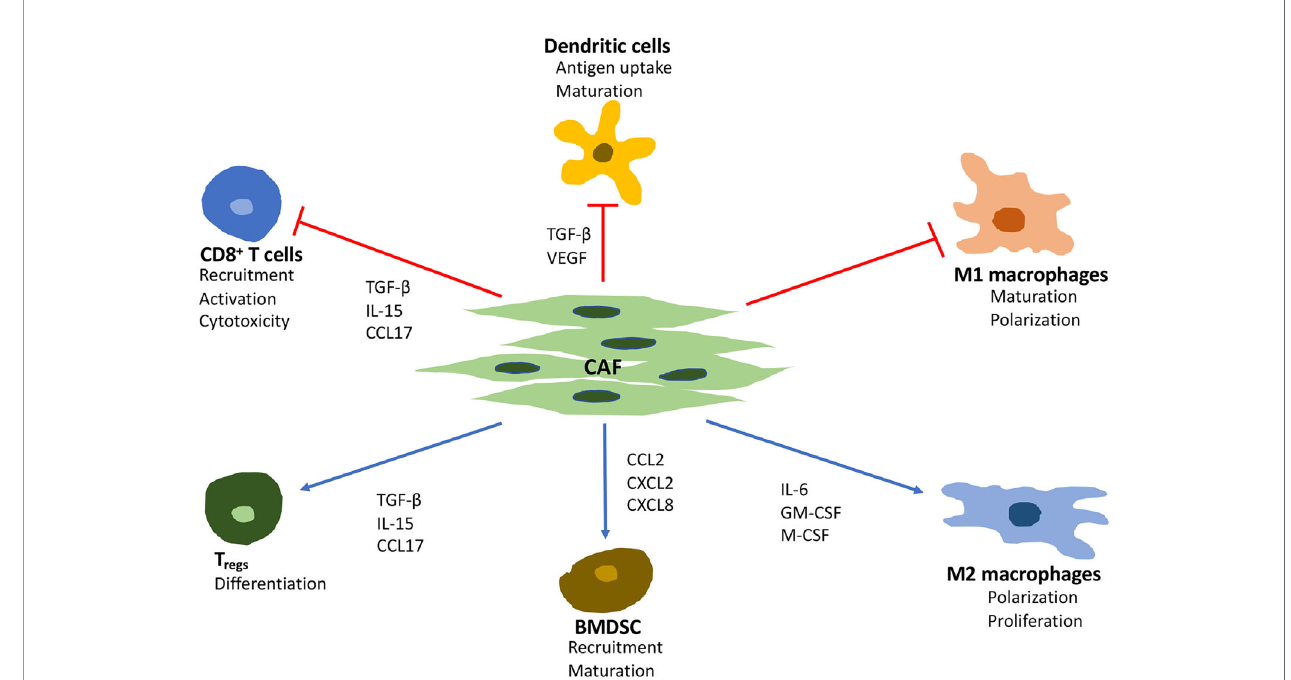
FIGURE 1 | Major effects of CAF on immune cells in the tumor microenvironment. TGF- b , transforming growth factor beta; VEGF, vascular endothelial growth factor; IL, interleukin 6; GM-CSF, granulocyte-macrophage colony-stimulating factor; M-CSF, macrophage colony stimulating factor; CCL, C-C motif chemokine ligand; CXCL, C-X-C motif